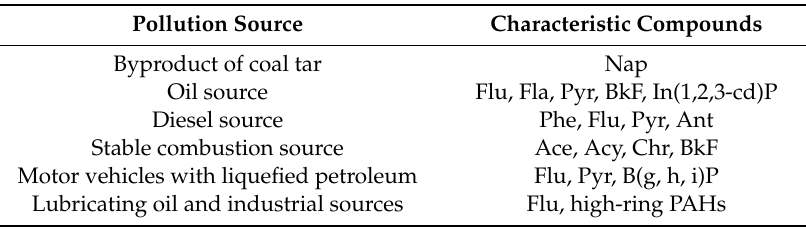
Table 3. Characteristic compounds emitted from various sources [23–28].